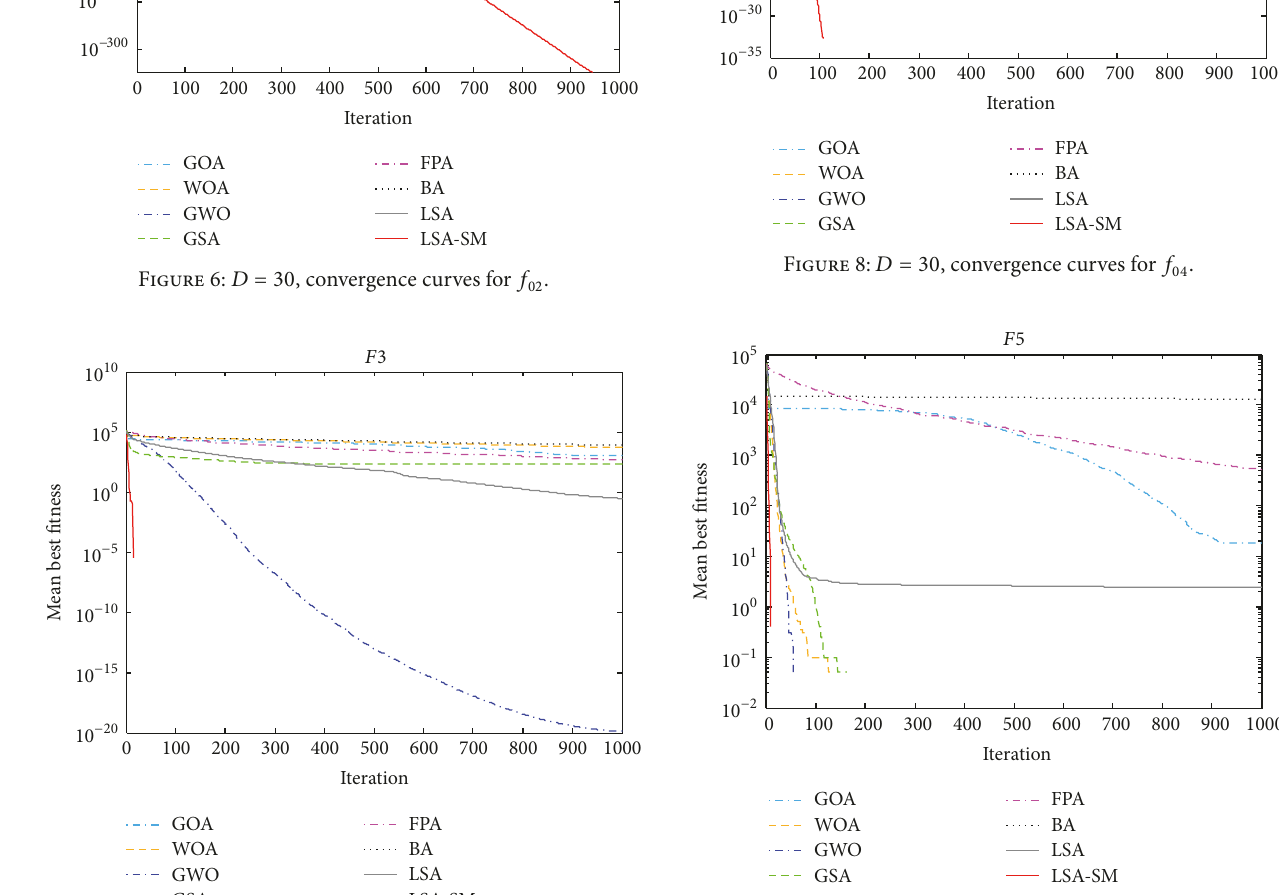
Figure 7: 𝐷 = 30 , convergence curves for 𝑓 03 .